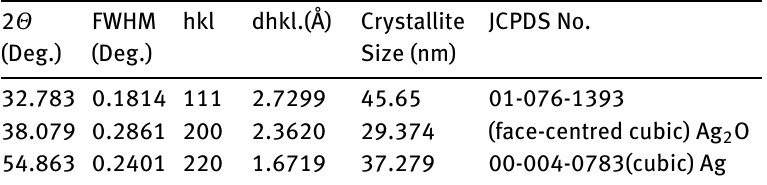
Table 1: Structural properties of green synthesized Ag 2 O